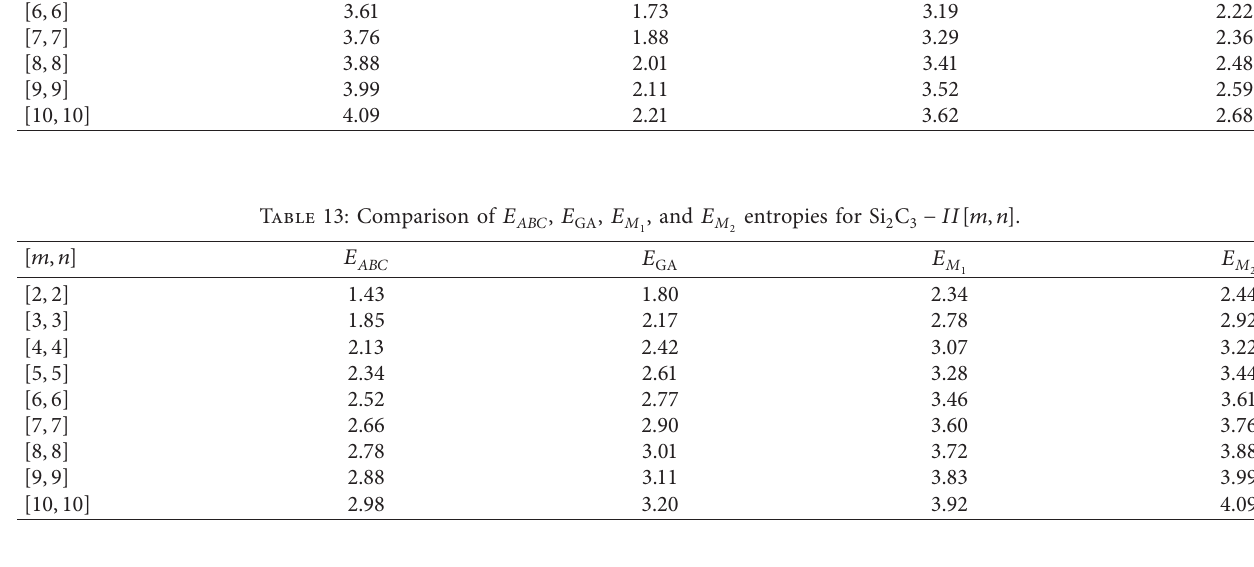
Table 14: Comparison of E